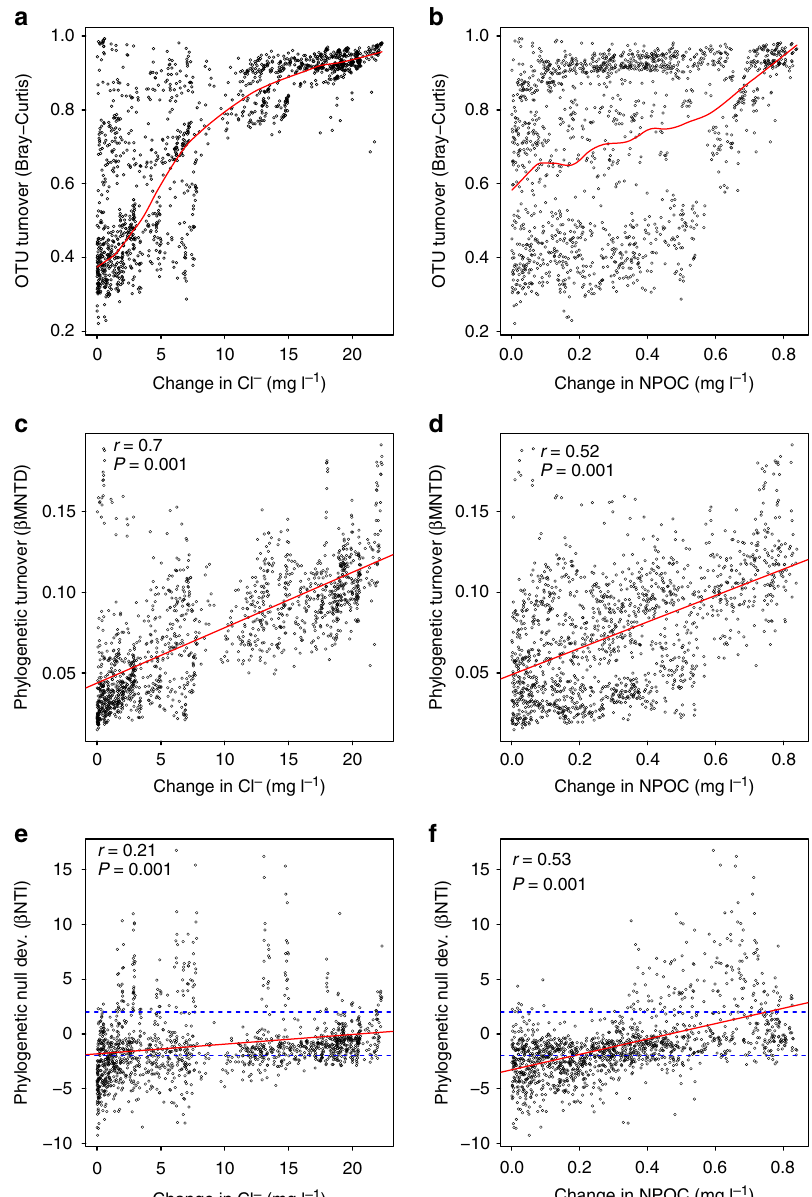
Figure 5 | Turnover in microbial community composition. Microbial community turnover in terms of composition ( a , b ), phylogeny ( c , d ) and phylogenetic null model deviation ( e , f ). Turnover metrics are related to either changes in Cl (cid:2) ( a , c , e ) or changes in NPOC ( b , d , f ). Solid red lines indicate a nonlinear spline fit ( a , b ) or linear models ( c – f ); dashed blue lines ( e , f ) indicate null model deviation significance thresholds; values above þ 2 or below (cid:2) 2 are considered significant. Mantel test statistics are